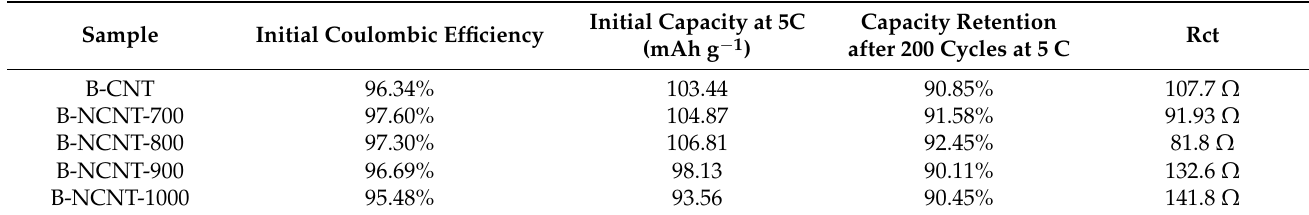
Table 4. Battery performance